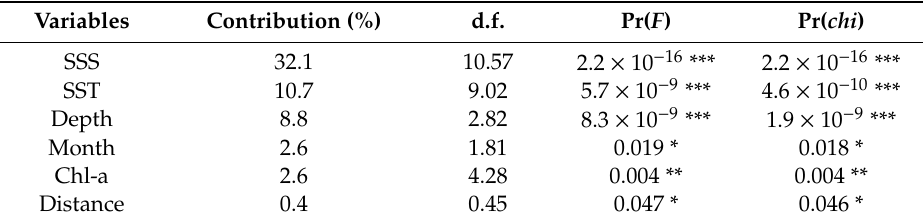
Table 2. Contributions of the selected variables in